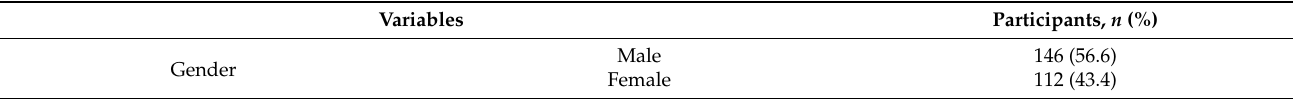
Table 1. School leaders’ characteristics, their works, perceived stress, health, COVID-19-related information and health literacy, sense of coherence and well-being ( n =